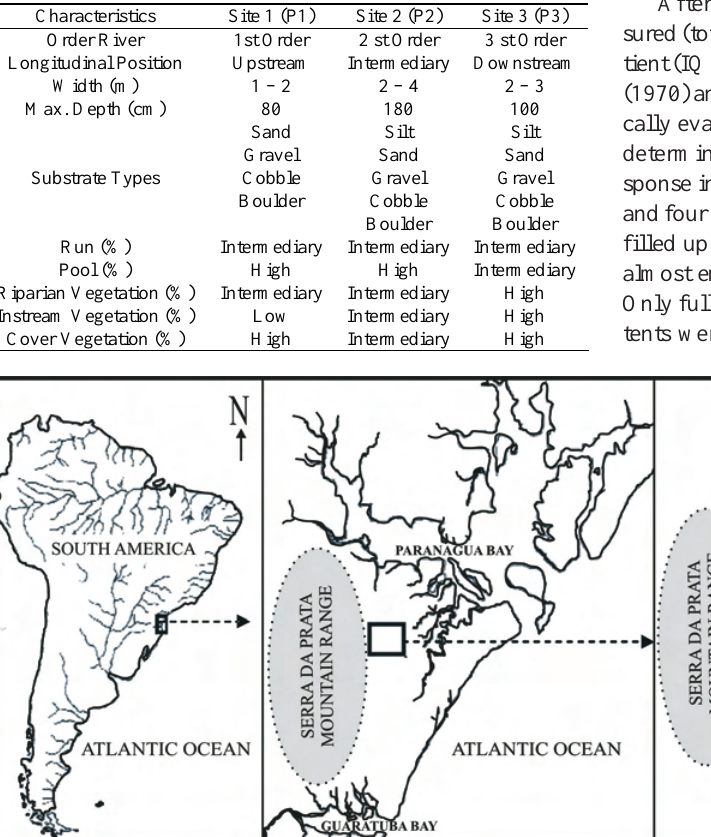
Fig. 2. Geographical location of the rio Ribeirão basin, with indication of the three sampling sites (P1, P2, and